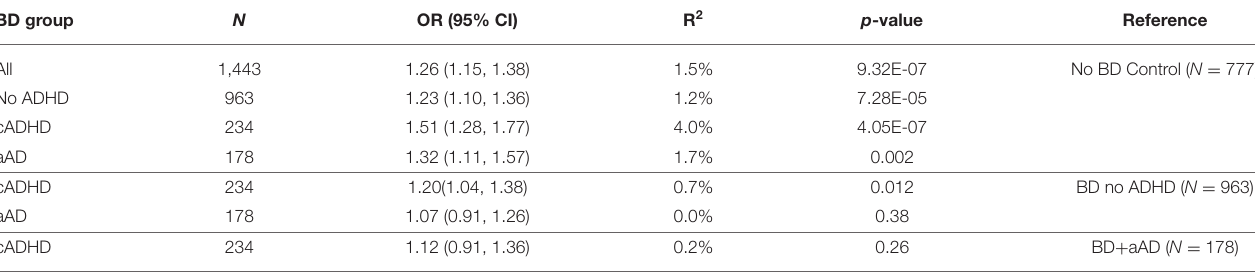
TABLE 2A | Associations of ADHD PRS with BD subtypes defined by cADHD and aAD. BD group